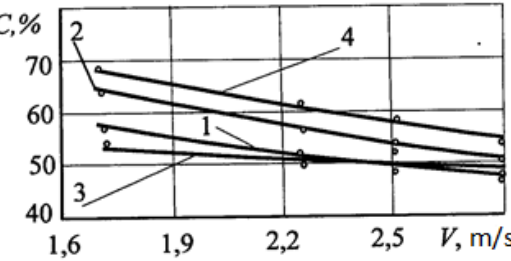
Figure 9. Influence of the speed of movement of the unit and the technological scheme of the tool on the presser– vation of stubble after the passage of the tool (Backg– round -